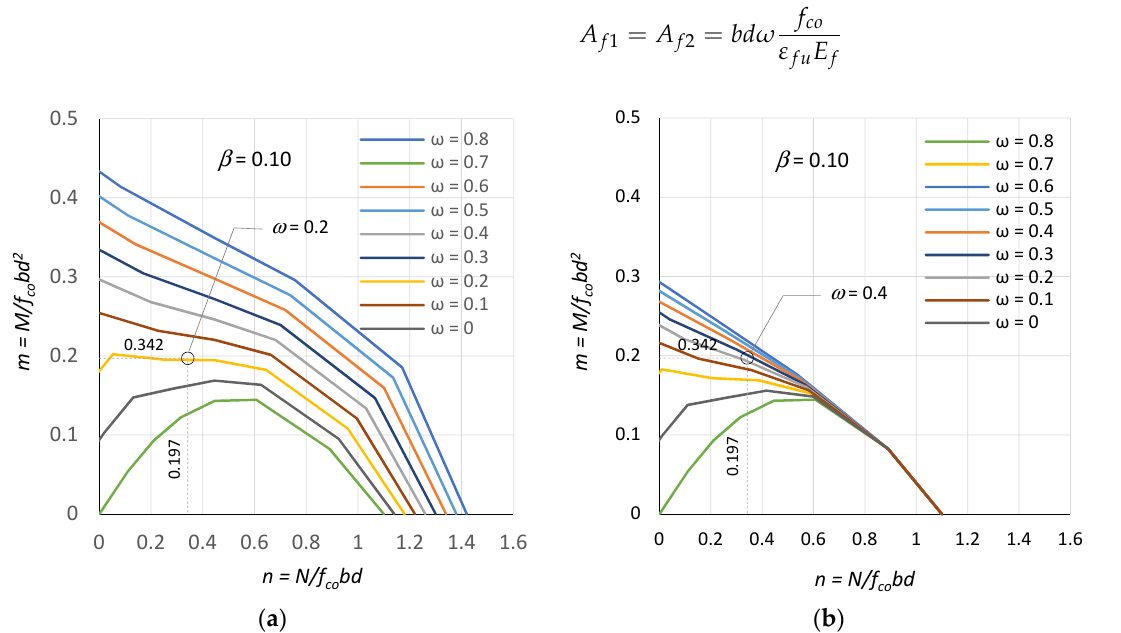
Figure 8. Curves of n–m interaction for sections: ( a ) with compression bars and ( b ) without compression bars.